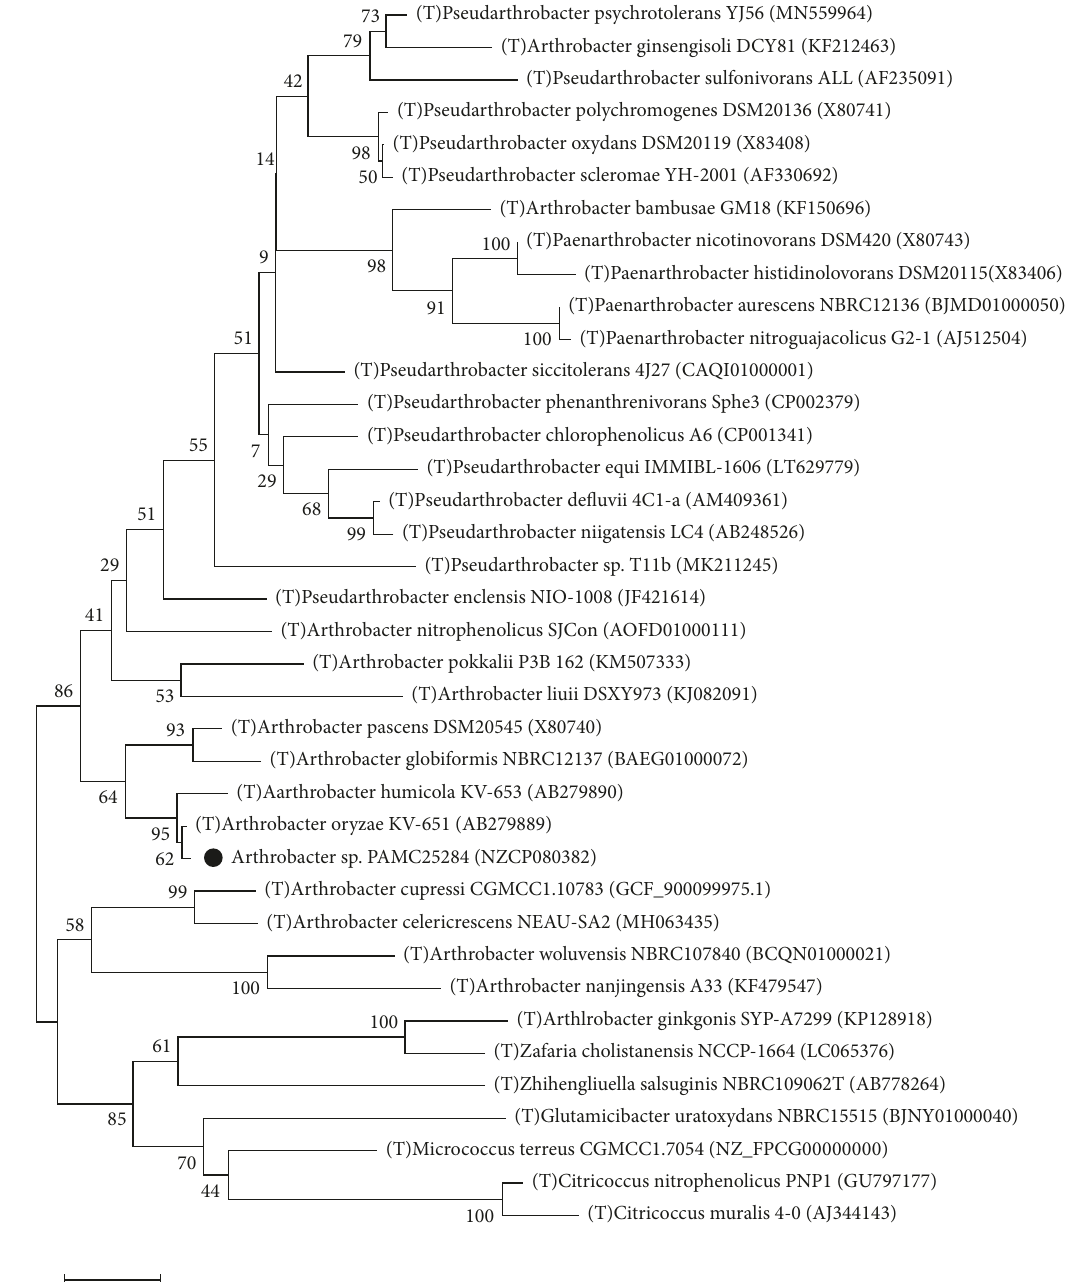
Figure 2: Neighbor joining phylogenetic tree based on 16S rRNA gene sequences showing the relationships between strain PAMC25284 (indicated with a red circle) and the type strains Tof related Arthrobacter species. The numbers at the nodes indicate the level of bootstrap support based on a maximum likelihood of 1,000 resampled datasets. Scale bar numbers of the sequences are indicated in